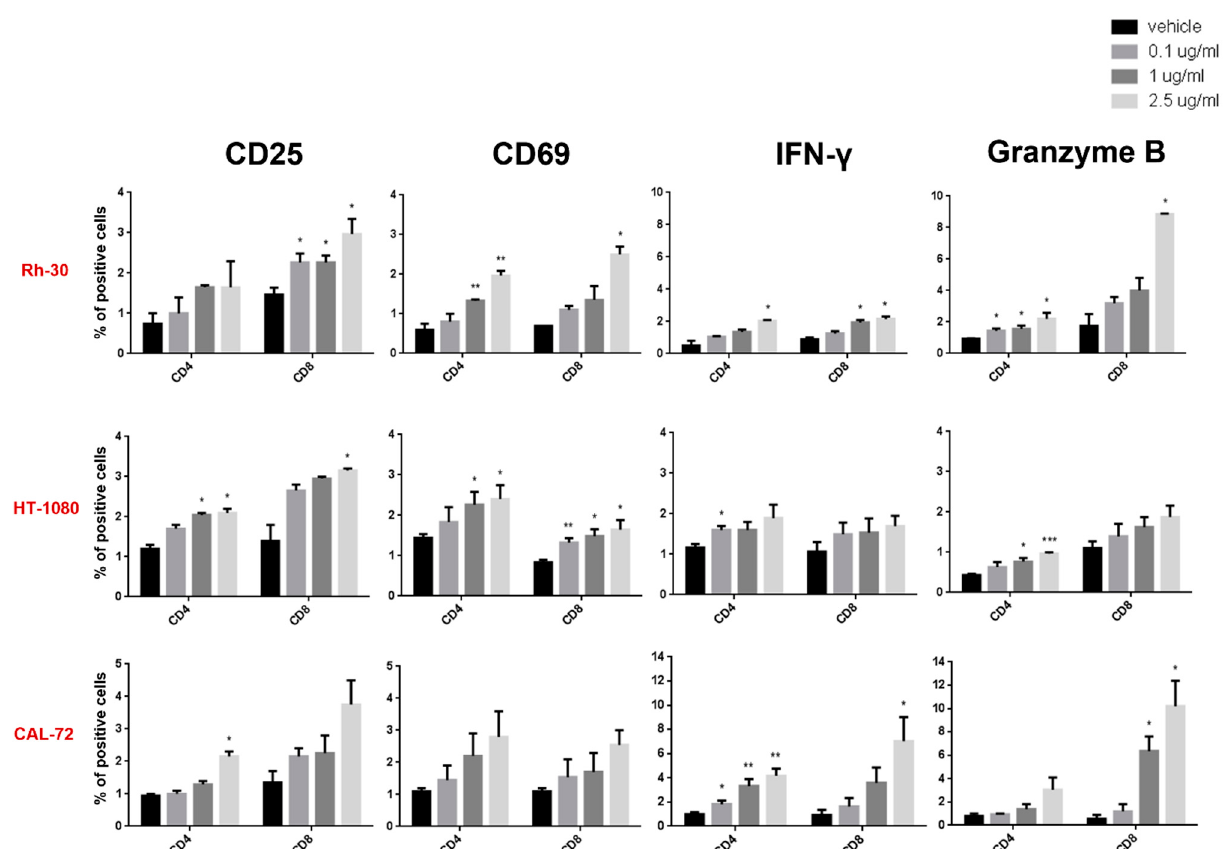
Figure 3. Functional experiments on CD4–CD8 gated T cells. Surface early and late activation markers (CD69 and CD25), cytokine release (IFN- γ ) and cytolytic enzyme (Granzyme B) on CD4 and CD8-positive T lymphocytes from at least 3 donors co-cultured with Rh-30, HT-1080 and CAL-72 sarcoma cell lines at 10:1 E:T ratio, in the presence of different concentrations of pAXL × CD3 ε . Each result is expressed as the mean value of triplicate experiments obtained from each donor. * p < 0.0332; ** p < 0.0021; *** p < 0.0002. Consistent with their cytotoxic function, T lymphocytes were also positive for CD107a degranulation marker (Figure 4A,B).